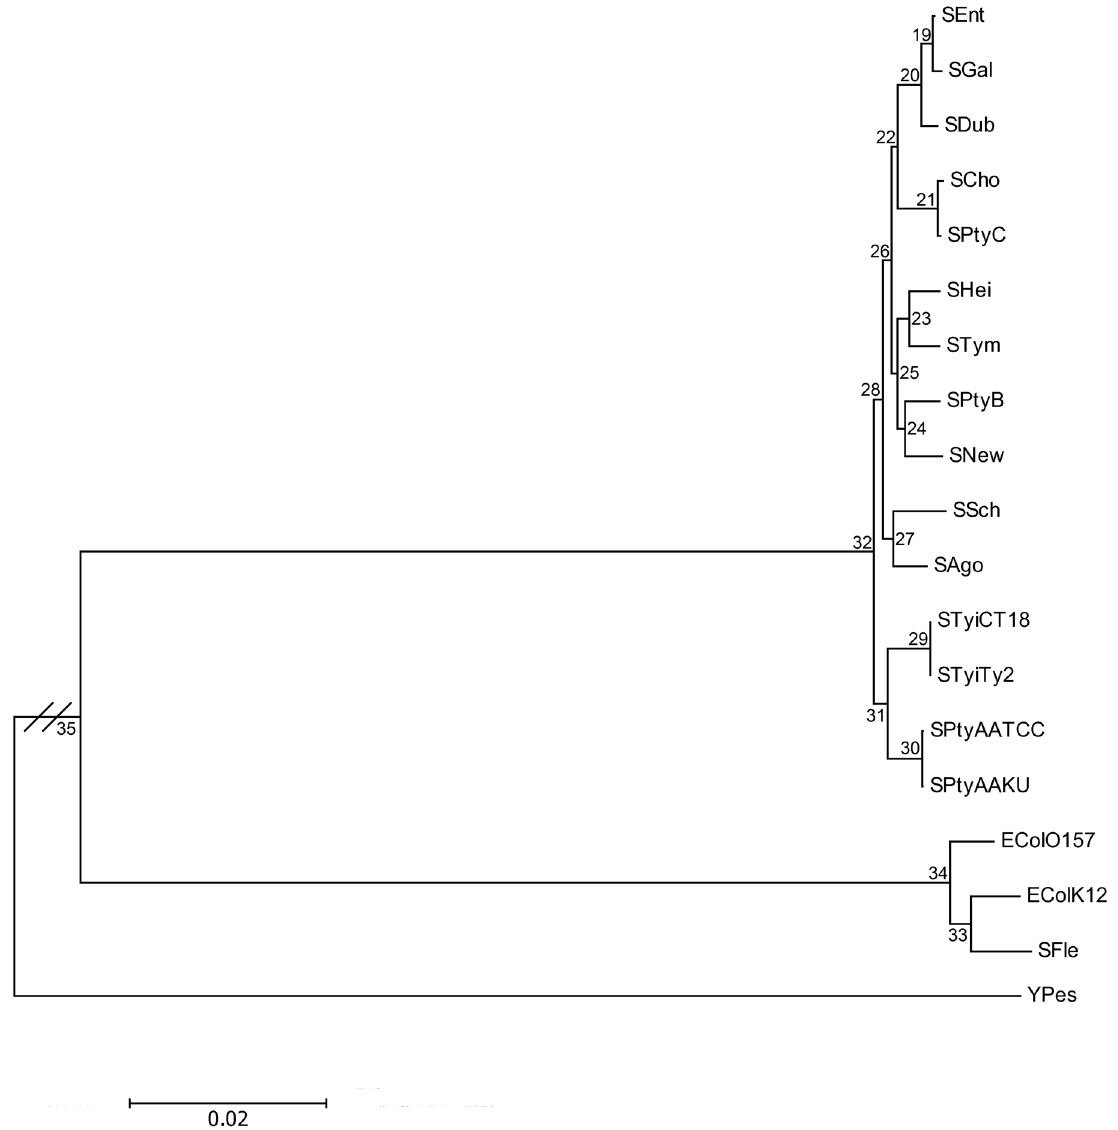
Figure 3. The ML phylogeny inferred from the four-fold degenerate sites of 474 genes. The internal nodes are labeled 19–35, with node 35 being the divergent point between E. coli and Salmonella and node 32 being the root node of the ingroup Salmonella .